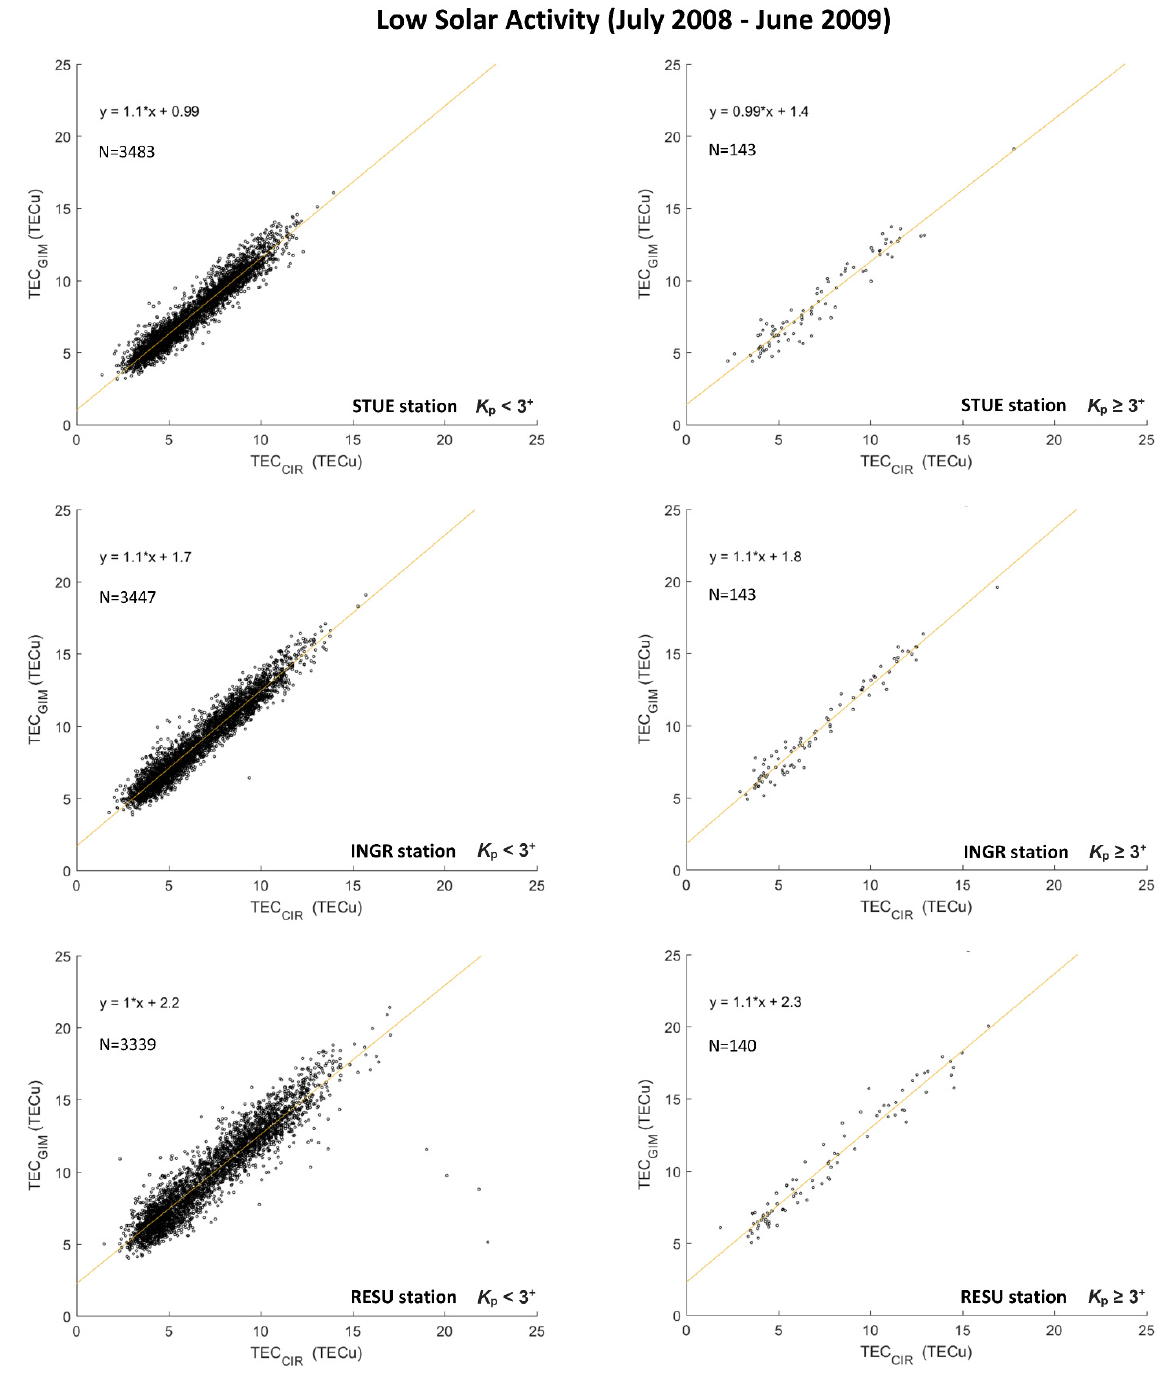
Figure 1. Scatterplots (TEC GIM vs. TEC CIR ) and corresponding linear regressions for STUE (upper row), INGR (middle row) and RESU (lower row) for the LSA period between July 2008 and June 2009. Left panels refer to quiet geomagnetic values ( K p < 3 + ), while right panels refer to disturbed geomagnetic values ( K p ≥ 3 + ). The number of considered measurements N is shown inside each plot.